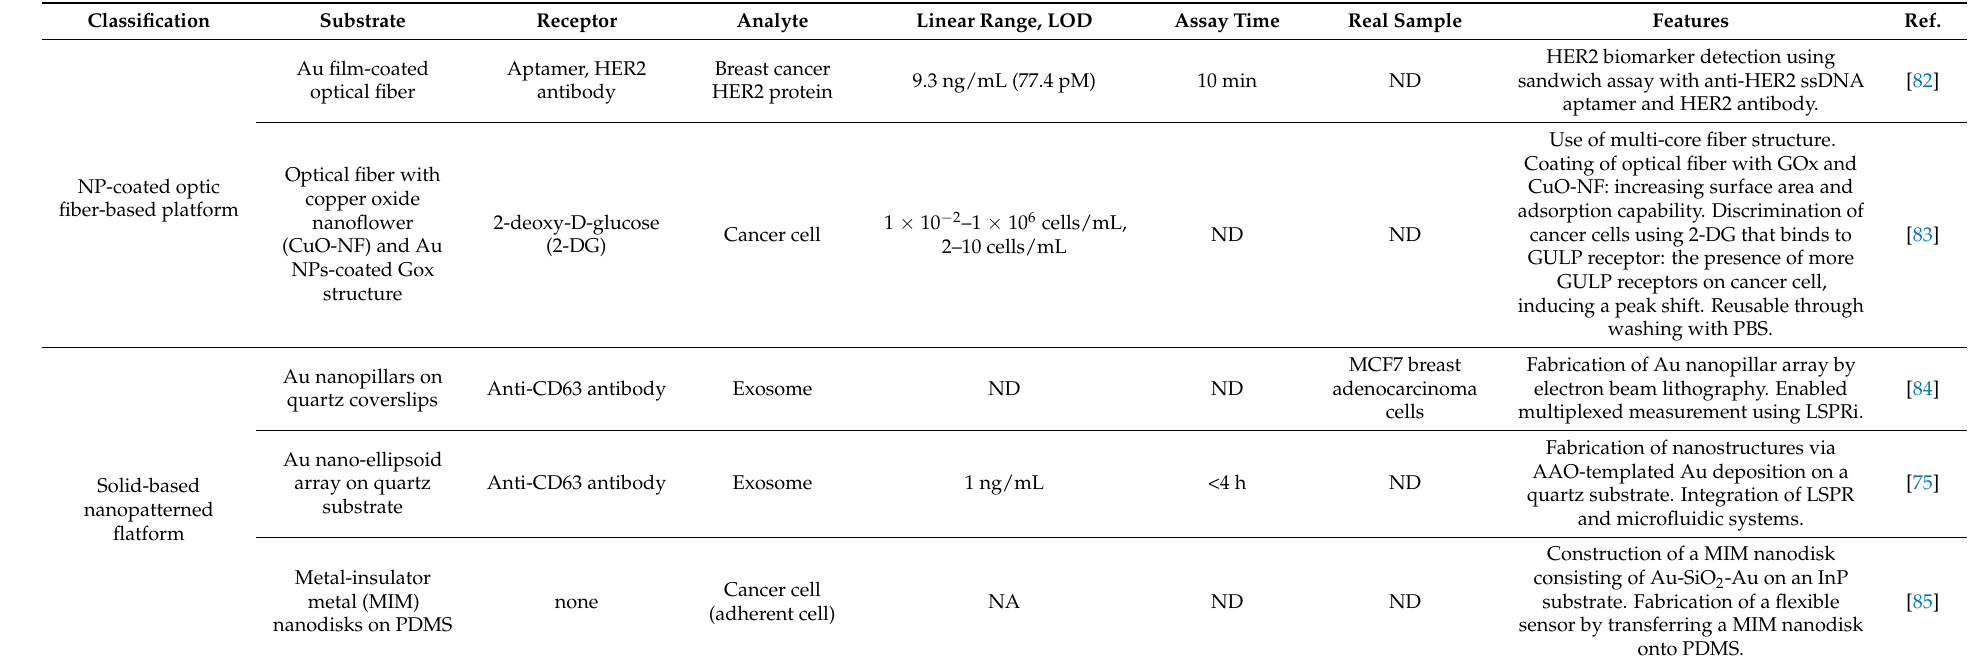
Table 3. Examples of nanostructure-based LSPR biosensors for the detection of various molecules 1 .